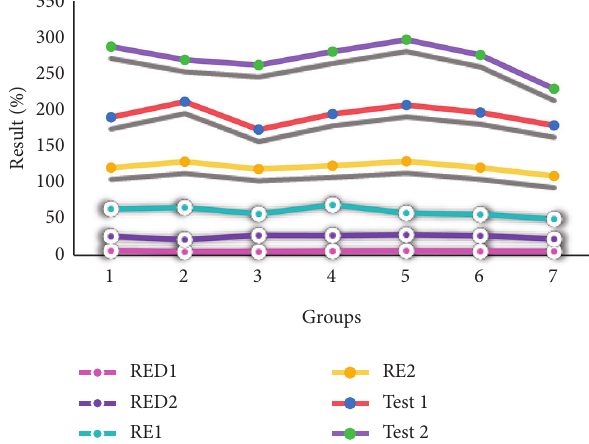
Figure 4: Cell survival rate in the environment of mesoporous multifunctional nanomaterials.